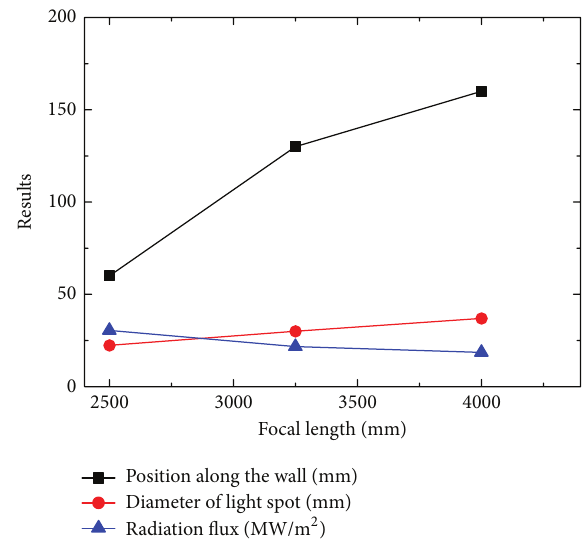
Figure 3: Effect of the focal length on the performance of concentrating